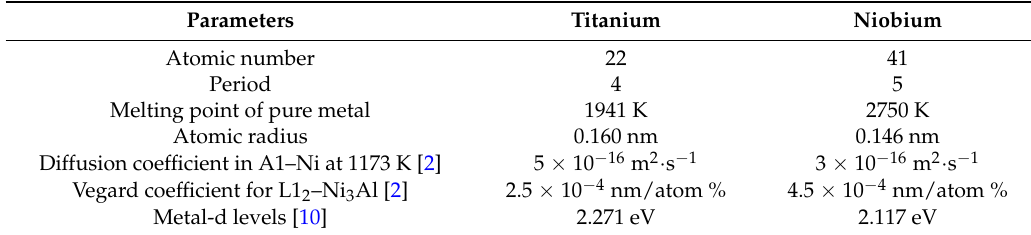
Table 1. Comparison between the design parameters for alloys containing Ti and